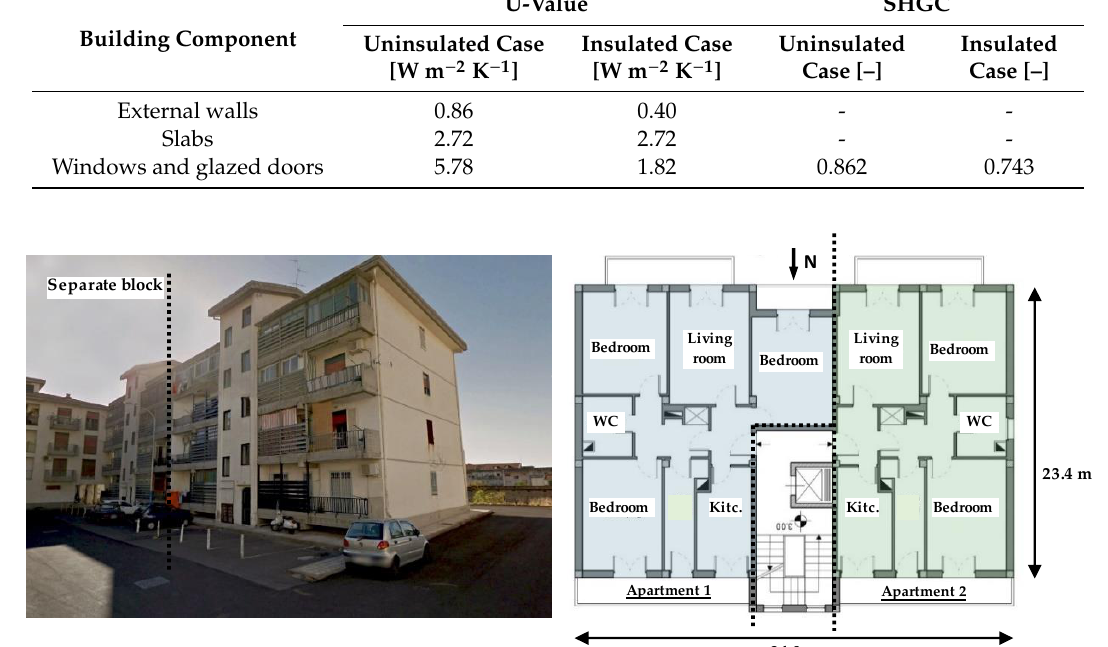
Figure 1. North view of the apartment block (left-hand side) and plan of a typical floor (right-hand side).